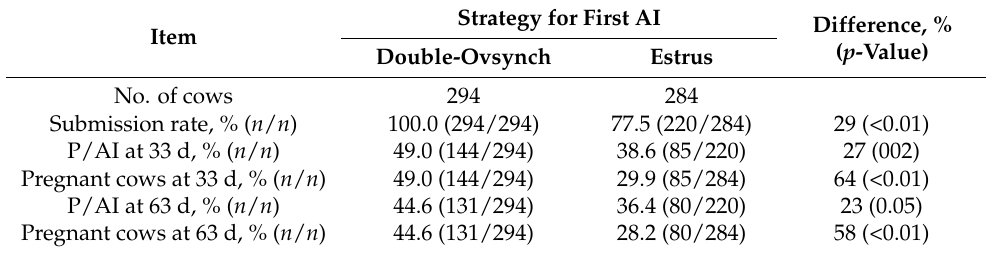
Table 5. Effect of Double-Ovsynch or management aimed to inseminate cows in estrus on submission rate, pregnancies per artificial insemination (P/AI) 33 and 63 d after insemination, and percentage of pregnant cows at 33 and 63 d after first insemination in lactating Holstein cows with similar days in